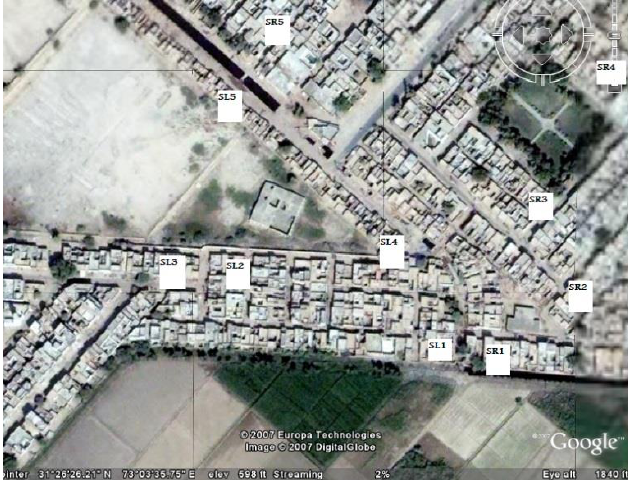
Figure 1: Arial photograph of the area with sampling points